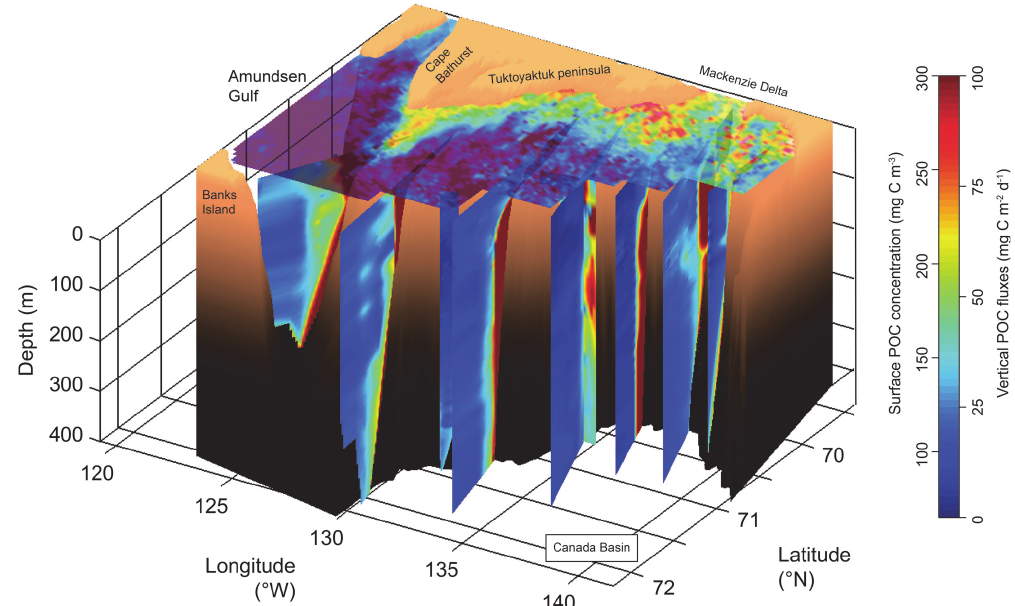
Fig. 9. Three-dimensional view of vertical POC fluxes across the Mackenzie Shelf region as estimated with the empirical power-law equations from the minimization procedure (Table 2) and applied to the whole UVP5 dataset from the ArcticNet-Malina 2009 campaign. Each vertical section corresponds to a specific transect as shown in Fig. 1. A MERIS composite of surface POC concentrations encompassing the period from 18 July–23 August 2009 is superimposed above the vertical POC fluxes. For convenience, we show only the vertical POC fluxes since the mass flux pattern is analogue to POC when using the UVP5 dataset – i.e., the percentage of POC in dry-weight fluxes averaged 18.7% ± 0.2% (within 95% confidence bounds, r 2 = 0 . 95). See also Appendix C and the online Supplement for an interactive visualization of vertical POC fluxes across the study region using geographic information system (EnterVol for ArcGIS, C Tech,